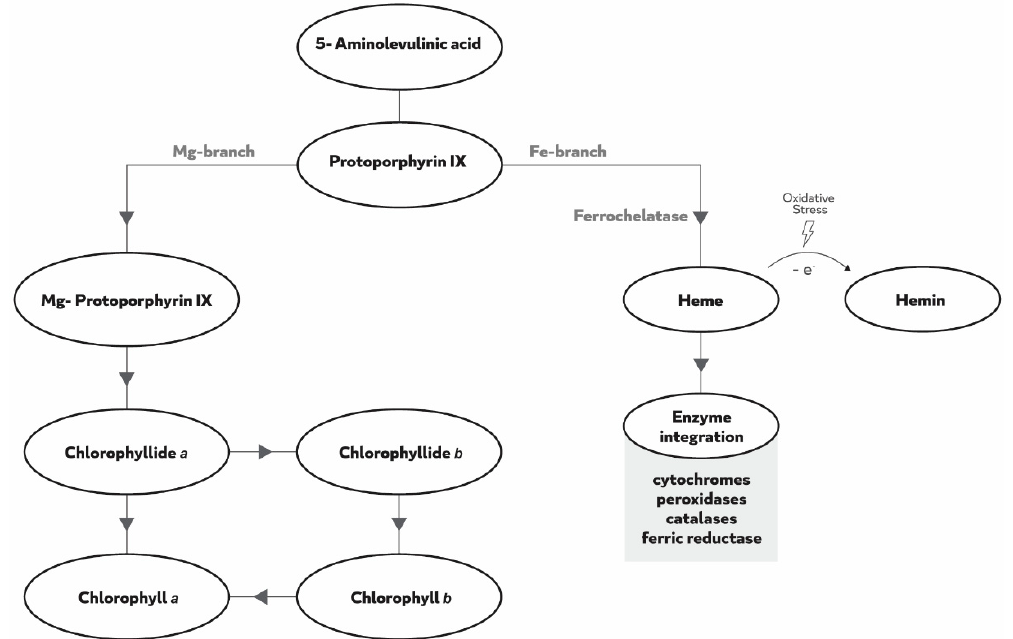
Figure 1. Schematic overview of the tetrapyrrole cycle.